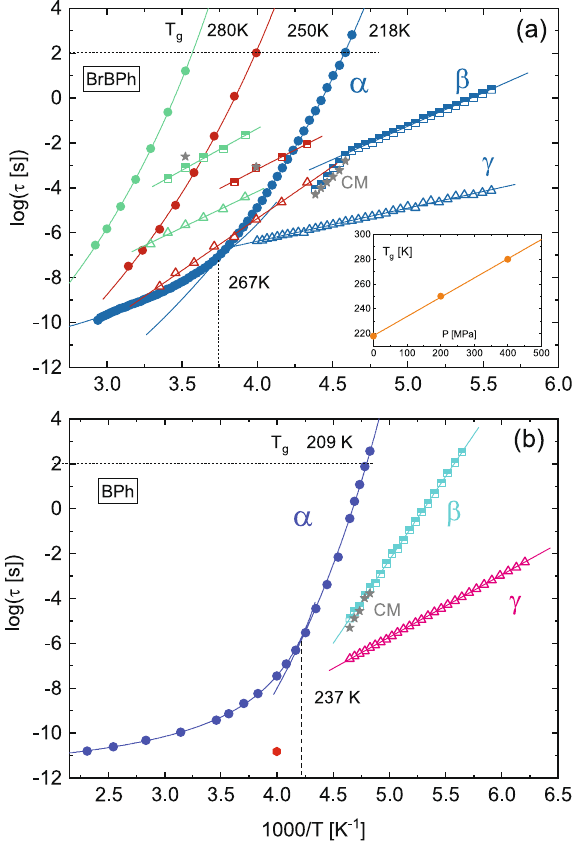
Figure 4. Arrhenius plot of the structural (α, filled circles) and secondary β (half-open squares) and γ (open triangles) relaxation times in BrBPh ( a ) and BPh ( b ). In ( a ), the data for all three studied pressures are reported (blue: 0.1 MPa; red, 201 MPa; green: 400 MPa). In ( b ), α relaxation times above T g were obtained by our own fits of the loss spectra of Ref. 27 , and the red dot represents the relaxation time of the fast-β relaxation inferred from analysis of the optical Kerr effect on BPh (Ref. 35 ). In both panels, continuous lines are VFT fits (Eq. 3) of the α relaxations or linear (Arrhenius law) fits of the secondary (β, γ) relaxation times. The dashed horizontal line marks the glass transition temperature T g , while the dashed vertical line marks the dynamic cross-over temperature at which the VFT temperature dependence of the α relaxation changes in the ambient pressure data. Stars represents the precursor times predicted by the Coupling Model (Eq. 5). Inset to ( a ): variation of T g with the applied pressure (markers). The line is a linear